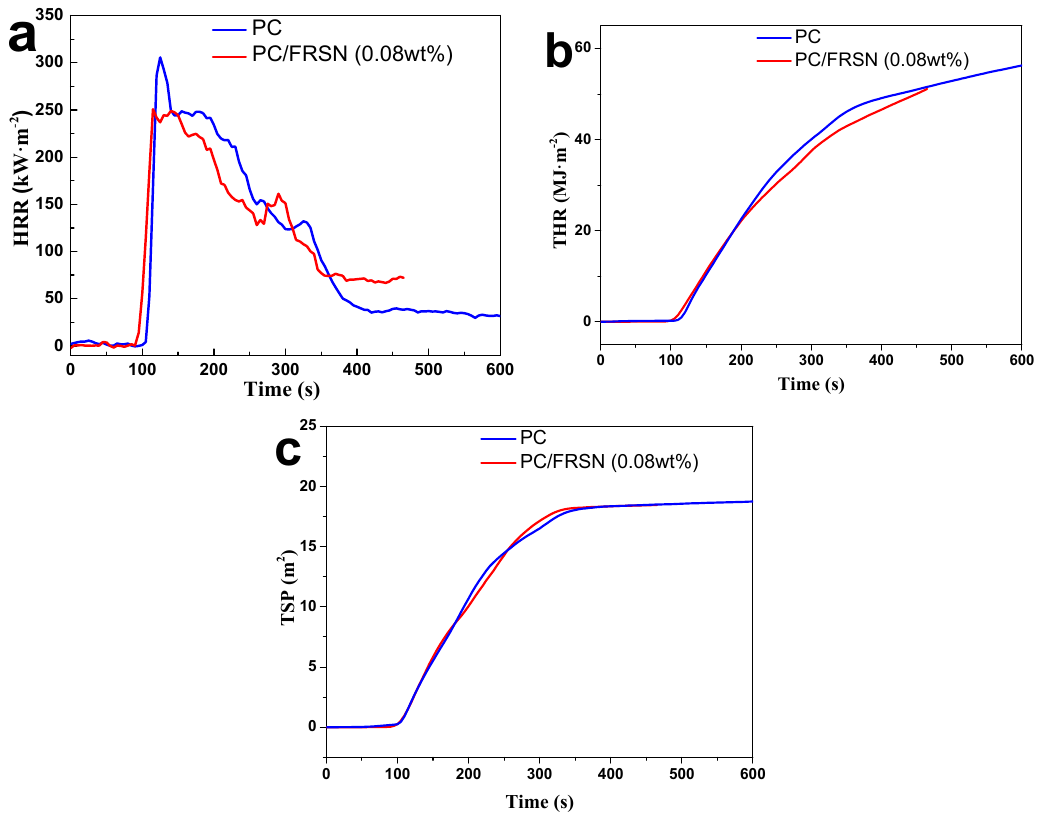
Figure 2. ( a ) HRR, ( b ) THR, and ( c ) TSP curves of PC and PC/FRSN (0.08 wt%).